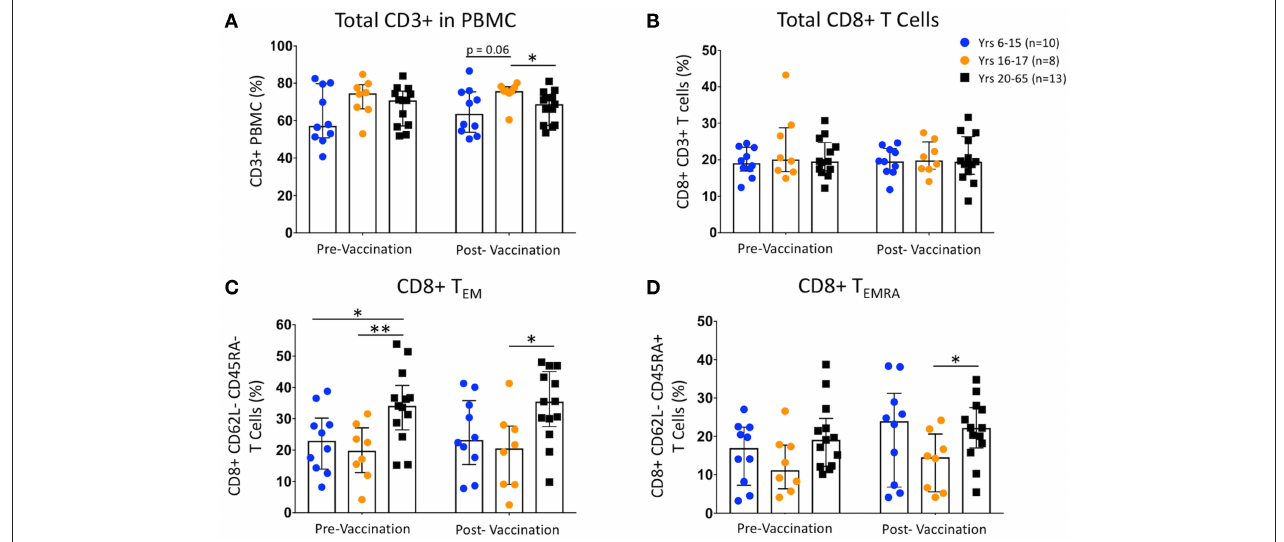
FIGURE 1 | Change in CD8T cell Populations Following Ty21a Vaccination. Scatter plots showing the percentages of (A) pre- and post-vaccination CD3 + T cells, (B) total CD8 + T cells, (C) CD8 + T effector memory (T EM ; CD45RA- CD62L-), and (D) CD8 + T EMRA (T EMRA ; CD45RA + CD62L-) populations among 6–15 year-old pediatric ( n = 10), 16–17 year-old pediatric ( n = 8), and adult ( n = 13) participants (media). Bars represent medians with whiskers indicating interquartile ranges. Statistics were analyzed by unpaired t -test (* p < 0.05; ** p <